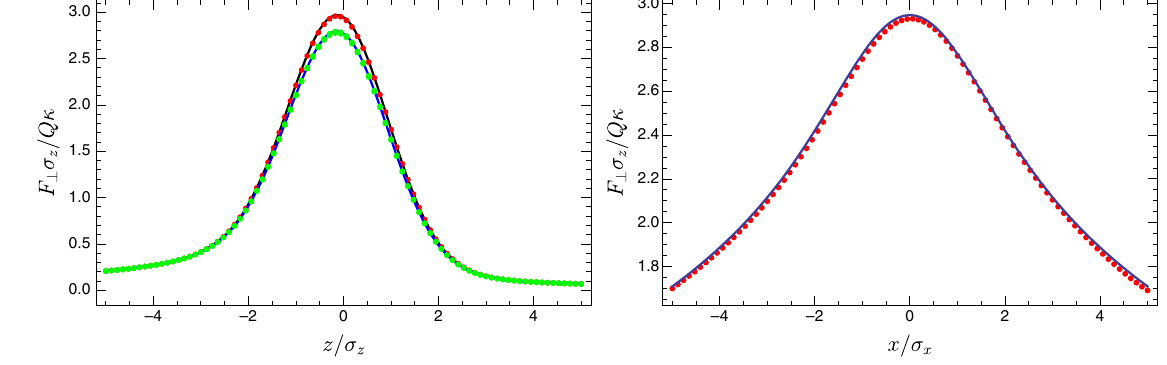
FIG. 2. Transverse force for the parameter set A. The solid black and blue lines are calculated using Eqs. (42) and (43) and the dots show the results of the numerical calculations with PyCSR3D. Left panel: dependence of F ⊥ versus z for r ¼ 0 (on axis) and r ¼ σ ⊥ , respectively (the values on the axis are larger than at r ¼ σ ⊥ ). Right panel: dependence of F ⊥ versus x for z ¼ 0 . The force is normalized by Q κ = σ z where Q is the charge of the The calculated profiles of the transverse force for the parameter set A are shown in Fig. 2. Because of the axisymmetry of the distribution function in this case, σ x ¼ σ y ¼ σ ⊥ , the function G ð x; y Þ in Eq. (42) depends only on the radial distance from the axis, r ¼